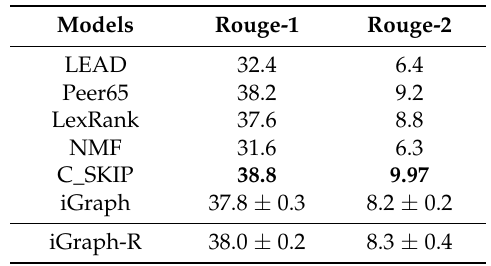
Table 4. The performance of various models on DUC 2004 using the limited length recall variants of Rouge at 100 words (665